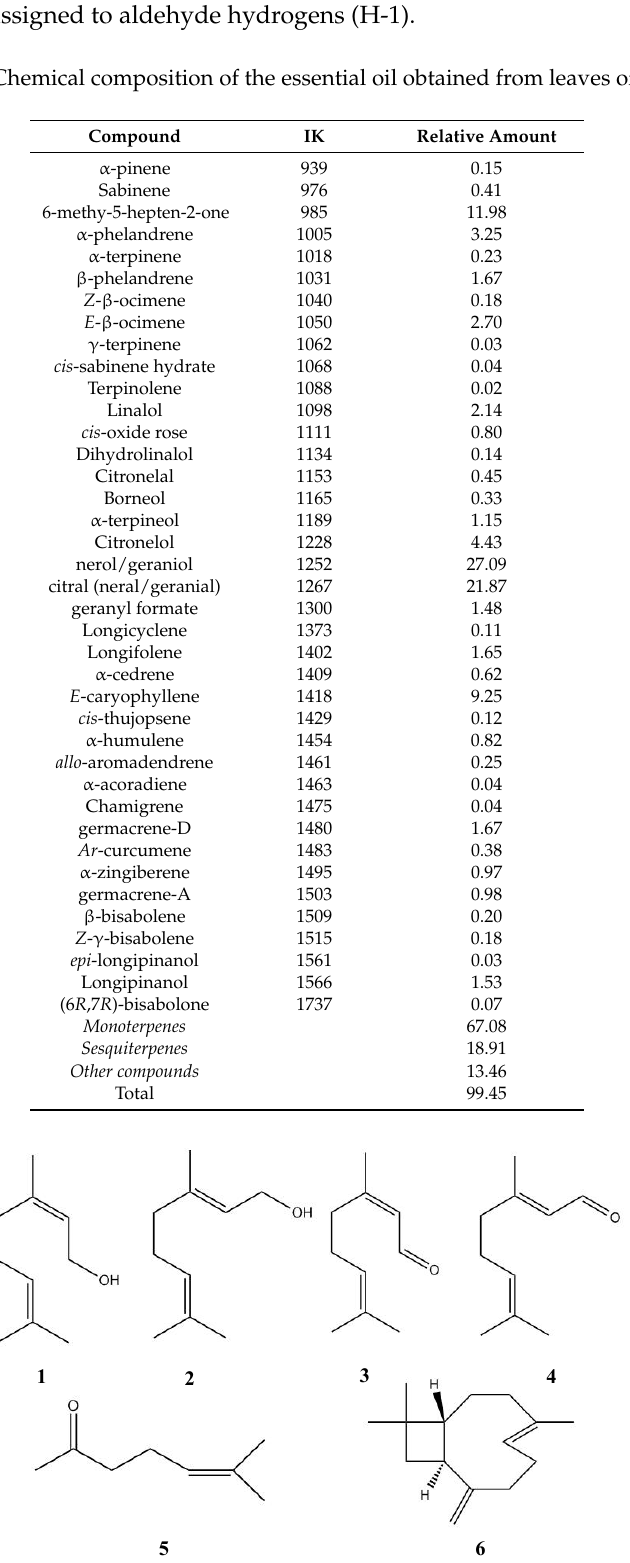
Figure 1. Structures of main compounds identified in essential oil from L. alba : nerol ( 1 ), geraniol ( 2 ), neral ( 3 ), geranial ( 4 ), 6-methy-5-hepten-2-one, ( 5 ) and E -caryophyllene ( 6 ).